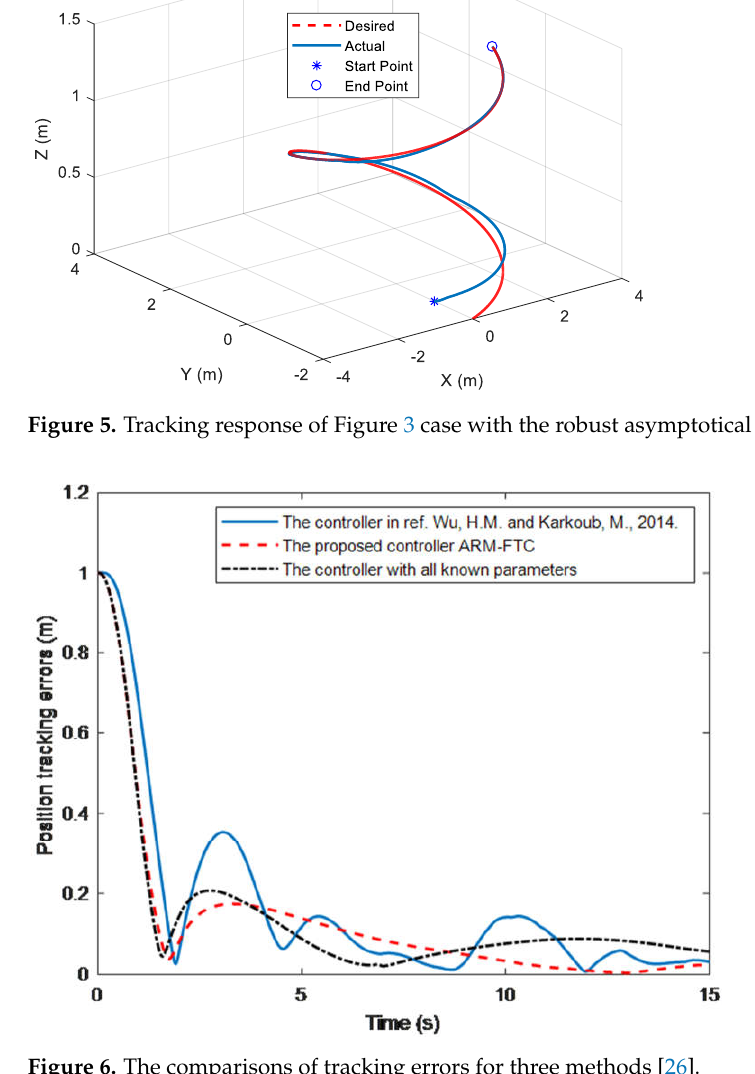
Figure 6. The comparisons of tracking errors for three methods